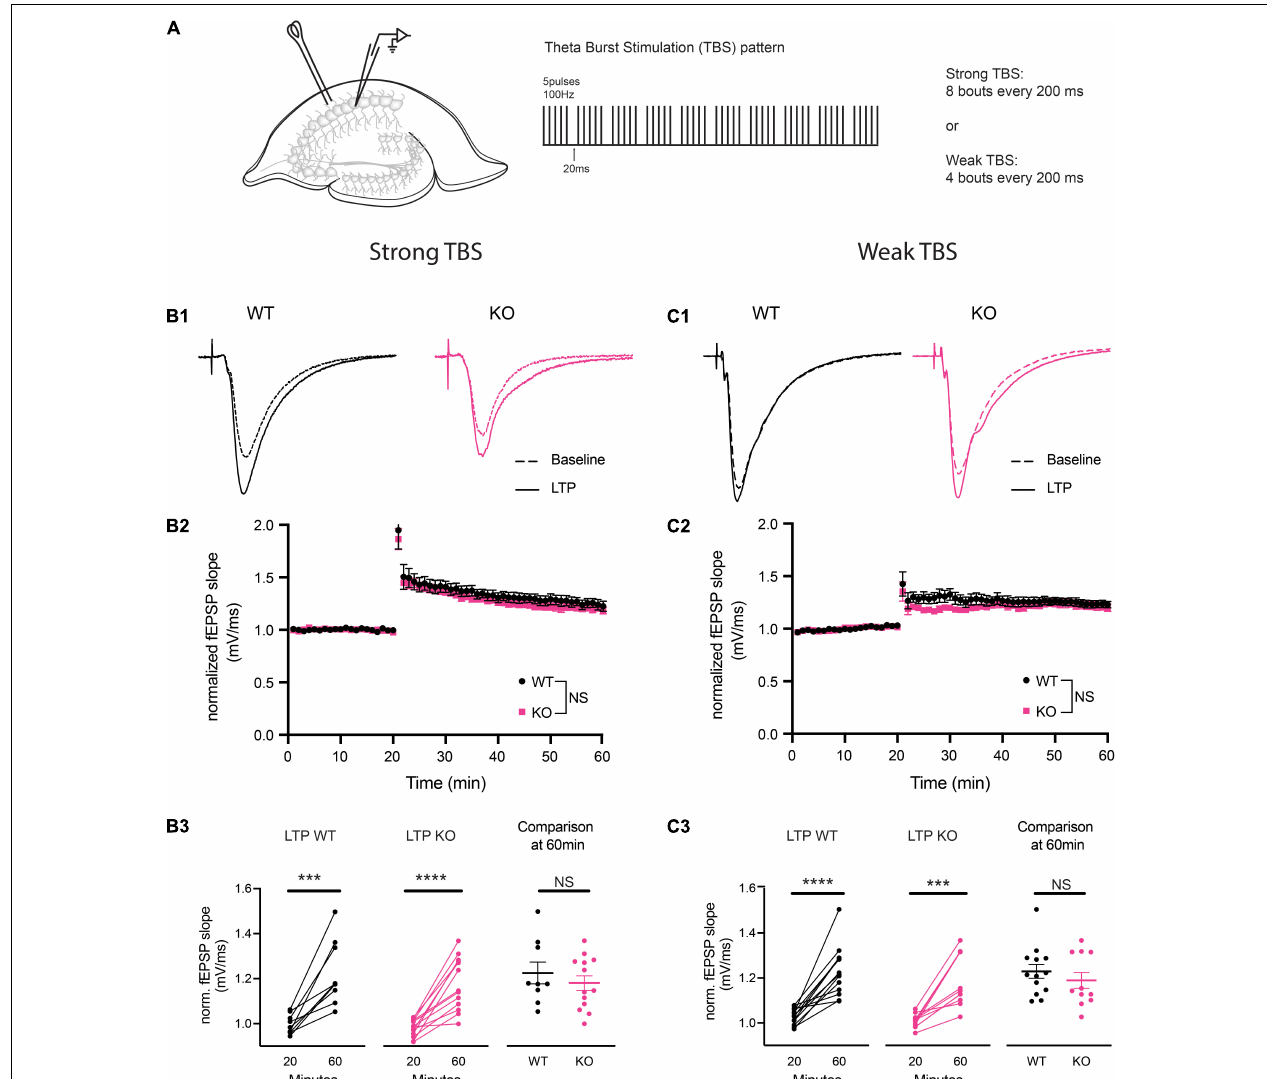
FIGURE 3 | Theta burst stimulation (TBS) induced long-term potentiation (LTP) was not different at CA3-CA1 synapses in PINK1 KO compared with WT littermate controls. (A) Schematic of stimulating and recording electrode in area CA1 of the hippocampus and the TBS pattern used to produce LTP (5 pulses of 100 Hz, each bout separated by 20 ms, repeated 10 times with 200 ms interstimulus interval). Initially, we performed LTP induction using a strong (8 bouts) TBS. To evaluate whether a strong TBS produced a ceiling effect at these synapses, we then induced LTP using a weak (4 bouts) TBS. Panels (B1,C1) show representative fEPSP traces from baseline and LTP induced by both strong and weak TBS from 4 months WT (black) and PINK1 KO (Pink) rats. Panels (B2,C2) show NMDA receptor (NMDAR) dependent LTP induction at CA3-CA1 synapses, following a 20 min stable baseline, using a strong TBS or a weak TBS. No statistical difference ( p > 0.05) was found after using Repeated measures two-way ANOVA [strong TBS: F (1,18) = 0.7216; weak TBS: F (1,22) = 1.301] between WT littermate controls (strong TBS: n = 9 slices/6 animals; weak TBS: n = 13 slice/4 animals) and PINK1 KO rats (strong TBS: n = 11 slices/7 animals; weak TBS: n = 11 slices/3 animals). Panels (B3,C3) show comparison of fEPSP slope at 20 min baseline and 60 min post TBS successfully induced LTP in both WT (strong TBS: p = 0.0007, paired t -test, t = 5.301, df =8; weak TBS: p = < 0.0001, paired t -test, t = 6.366, df = 12) and PINK1 KO (strong TBS: p = < 0.0001, paired t -test, t = 6.542, df = 12; weak TBS: p = 0.0002 paired t -test, t = 5.549, df = 10) rats. However, no change was detected between WT and PINK1 KO rats when compared at 60 min post LTP induction (strong TBS: p = 0.4299; Unpaired Student’s t -test, t = 0.8056, df = 20; weak TBS: p = 0.3980; unpaired Student’s t -test, t = 0.8619, df =